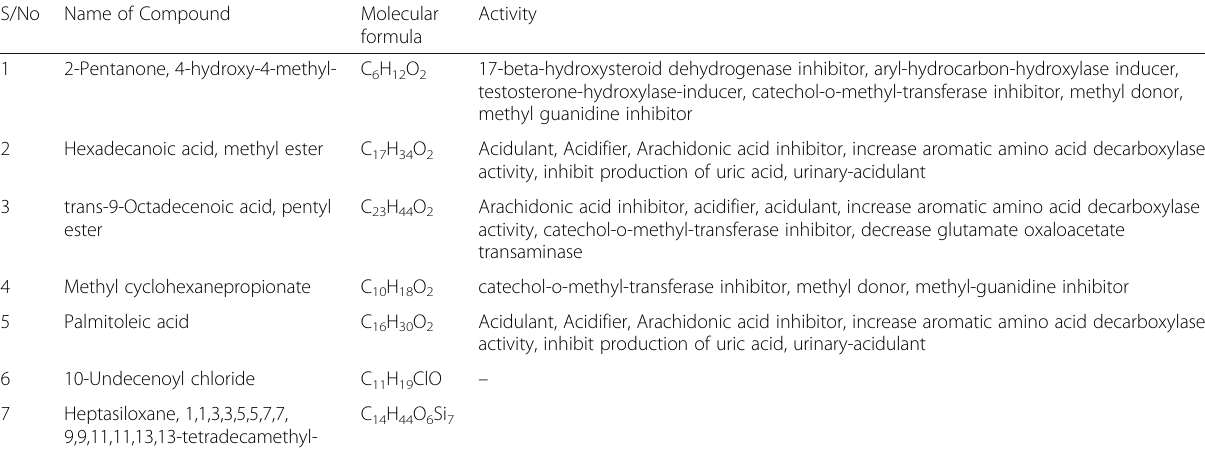
Table 7 Activity of Compounds Identified in the GCMS Study of Ethanol Extract of Feretia apodanthera Root